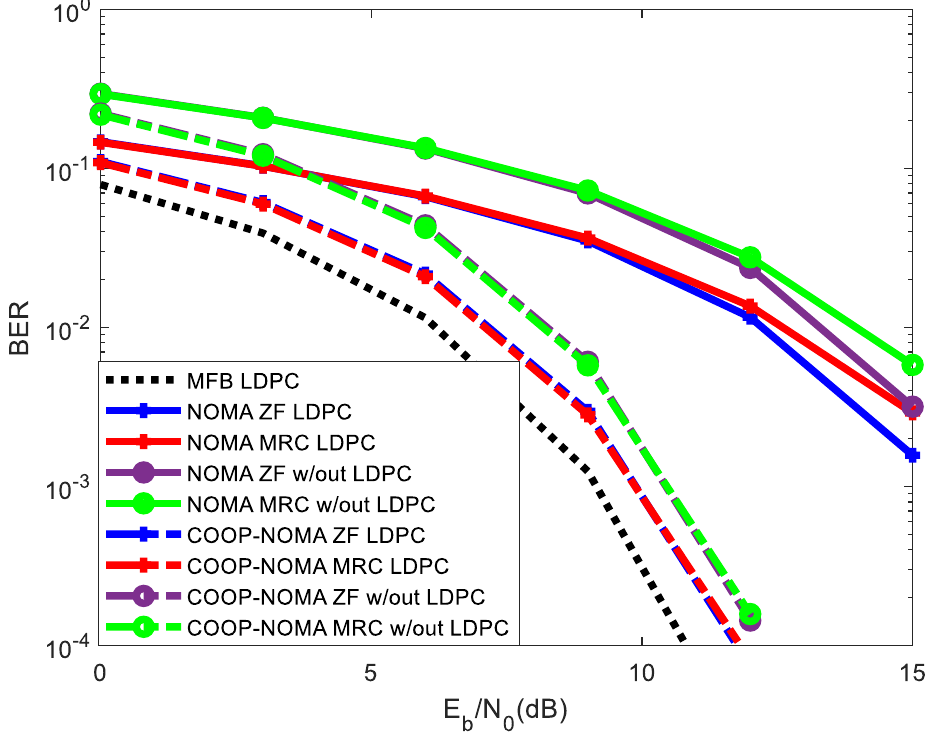
Figure 5. Results for 3 NOMA users with powers [1 0.5 2], with 8X64 MIMO (with and without LDPC codes).